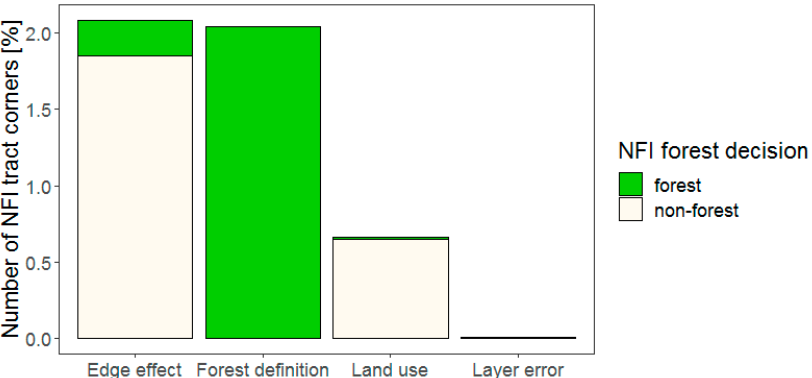
Figure 9. Statistical distribution of the incongruent NFI plots. The number of NFI tract corners is related to the total number of NFI tract corners evaluated.